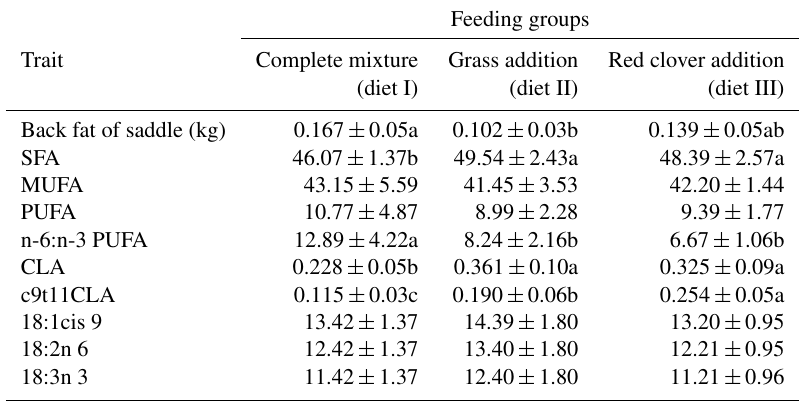
Table 2. The differences in selected fatty acid content estimated in lamb longissimus dorsi muscle depending on feeding system. Fatty acid contents are presented as g100g − 1 of total fatty acids in muscle samples.